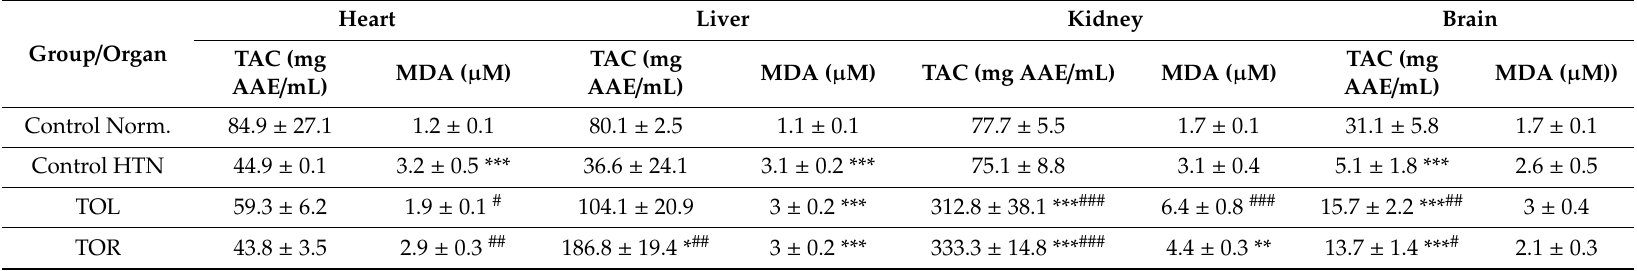
Table 3. E ff ect of treatment with TOL and TOR on tissue TAC and MDA levels after 21 days.